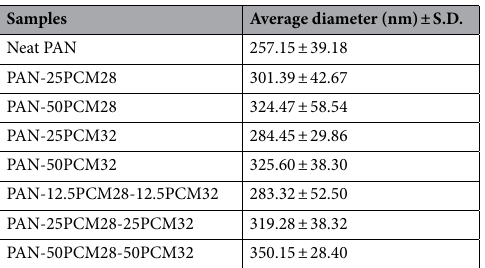
Table 3. Average diameters of neat PAN and composite PAN/PCM nanofibers.